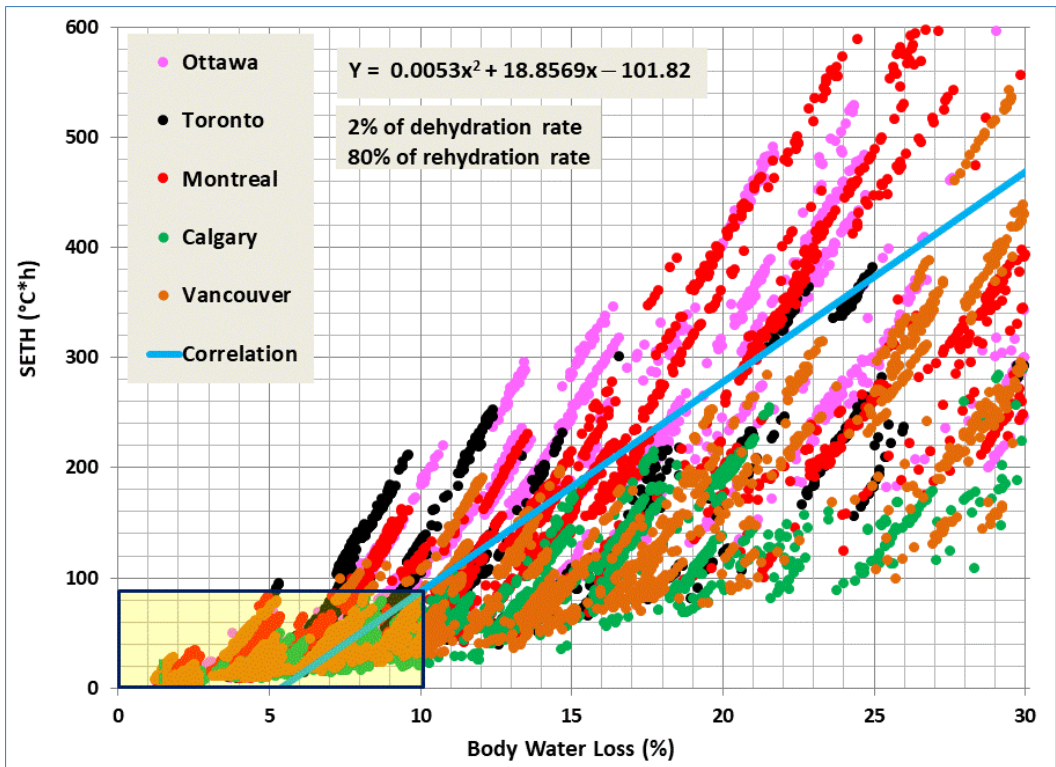
Figure 9 . Severity of overheating events versus body water loss in LTCHs. Figure 9. Severity of overheating events versus body water loss in